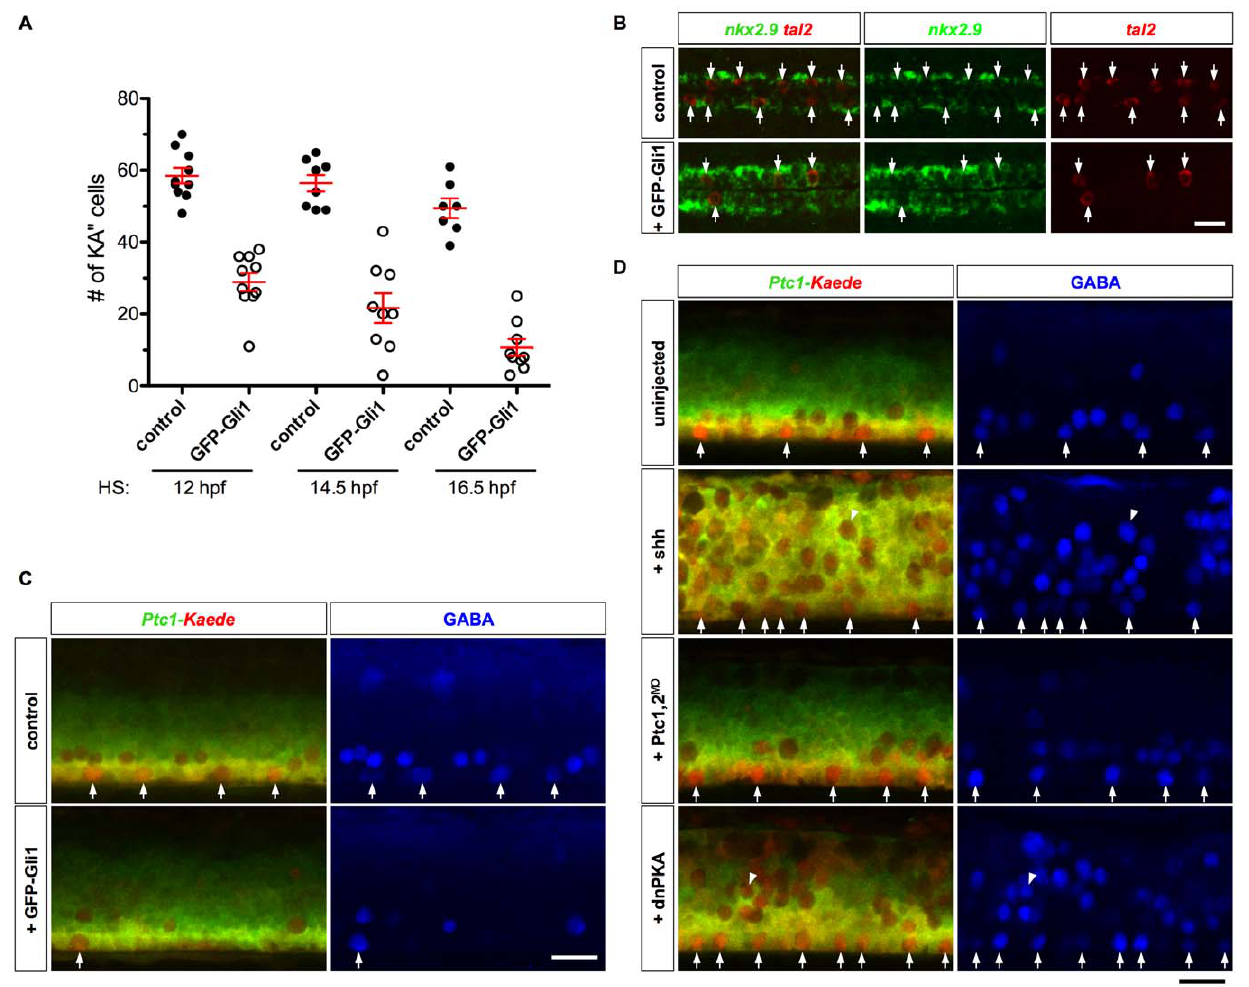
Figure 5. Prolonged Hh response interferes with KA 0 specification. (A) Quantification of KA 0 specification in embryos overexpressing GFP- Gli1. hsp-GFP-Gli1 embryos and their non-transgenic sibling controls were heat-shocked at indicated stages, and stained at 25 hpf for the expression of tal2 . (B) hsp-GFP-Gli1 and control embryos were heat-shocked at 14 hpf, and stained at 24 hpf for the expression of tal2 and nkx2.9 . Induction of GFP-Gli1 results in a reduction of tal2 -positive KA 0 cells (arrows) and expansion of nkx2.9 -expressing LFPs. (C) Ptc1-Kaede control embryos, and Ptc1- Kaede; hsp-GFP-Gli1 embryos were heat-shocked at 14 hpf, photoconverted at 24 hpf, and stained with the GABA antibody (blue) at 36 hpf. Induced expression of GFP-Gli1 results in a reduction of KA 0 cells (arrows). Note that at 36 hpf, GFP-Gli1 expression has minimal contribution to the green fluorescence. (D) Ptc1-Kaede control embryos, and Ptc1-Kaede embryos injected with Shh mRNA, Ptc1 and Ptc2 morpholinos, or dnPKA mRNA were photoconverted at 24 hpf, and stained with the GABA antibody (blue) at 36 hpf. Arrows indicated GABA-positive cells in the LFP domain. Note that Shh and dnPKA overexpression induced many ectopic GABAergic neurons (arrowheads) throughout the dorsal-ventral axis of the spinal cord, and most of them appeared to lose Hh response by 24 hpf as indicated by the expression of Ptc1-Kaede red . Scale bars: 20 m